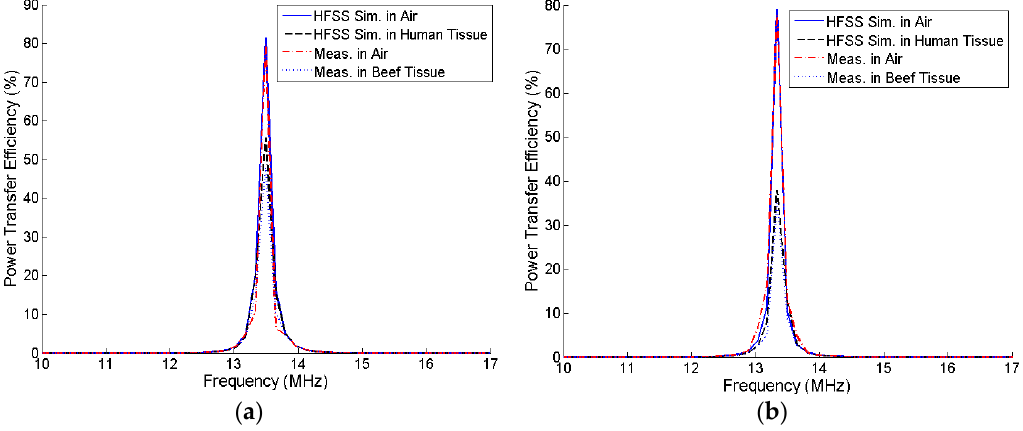
Figure 21. Comparison of the simulated PTE between the air and three-layered human-tissue media at resonance. ( a ) Square coil; ( b ) Circular coil.